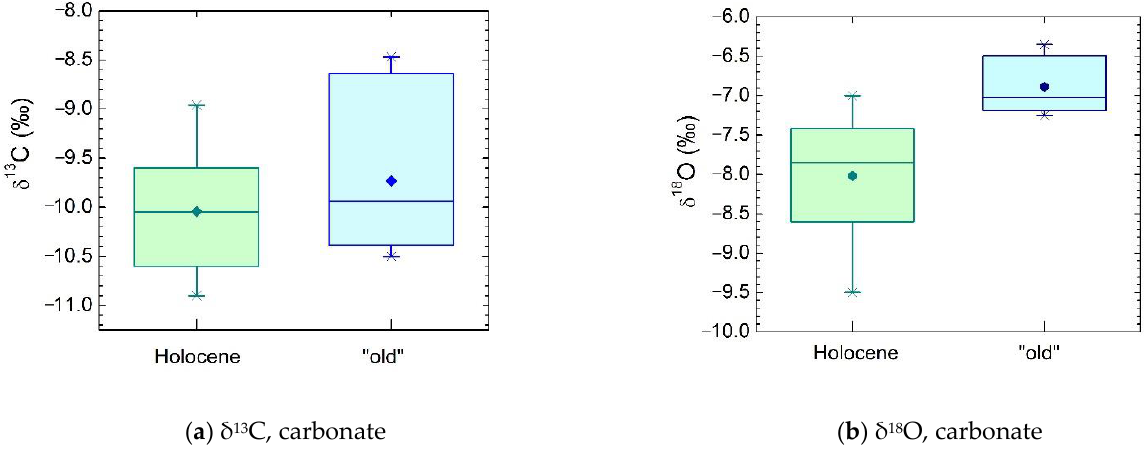
Figure 2. Box-plot of ( a ) δ 13 C and ( b ) δ 18 O values for Holocene and “old” samples. Data for the Holocene tufa samples taken from Table 2 and [64]. Table 4. The a 14 C difference between organic/humin and carbonate fractions, 14 C reservoir corrected calibrated ages of tufa carbonate fractions from the Sanaderi location ( a 0 = 84.5 ± 0.3 pMC, R = 1350 ± 20 years), and calibrated ages of organic residues ( a 0 = 97.0 ± 0.9 pMC, R = 240 ± 70 years).